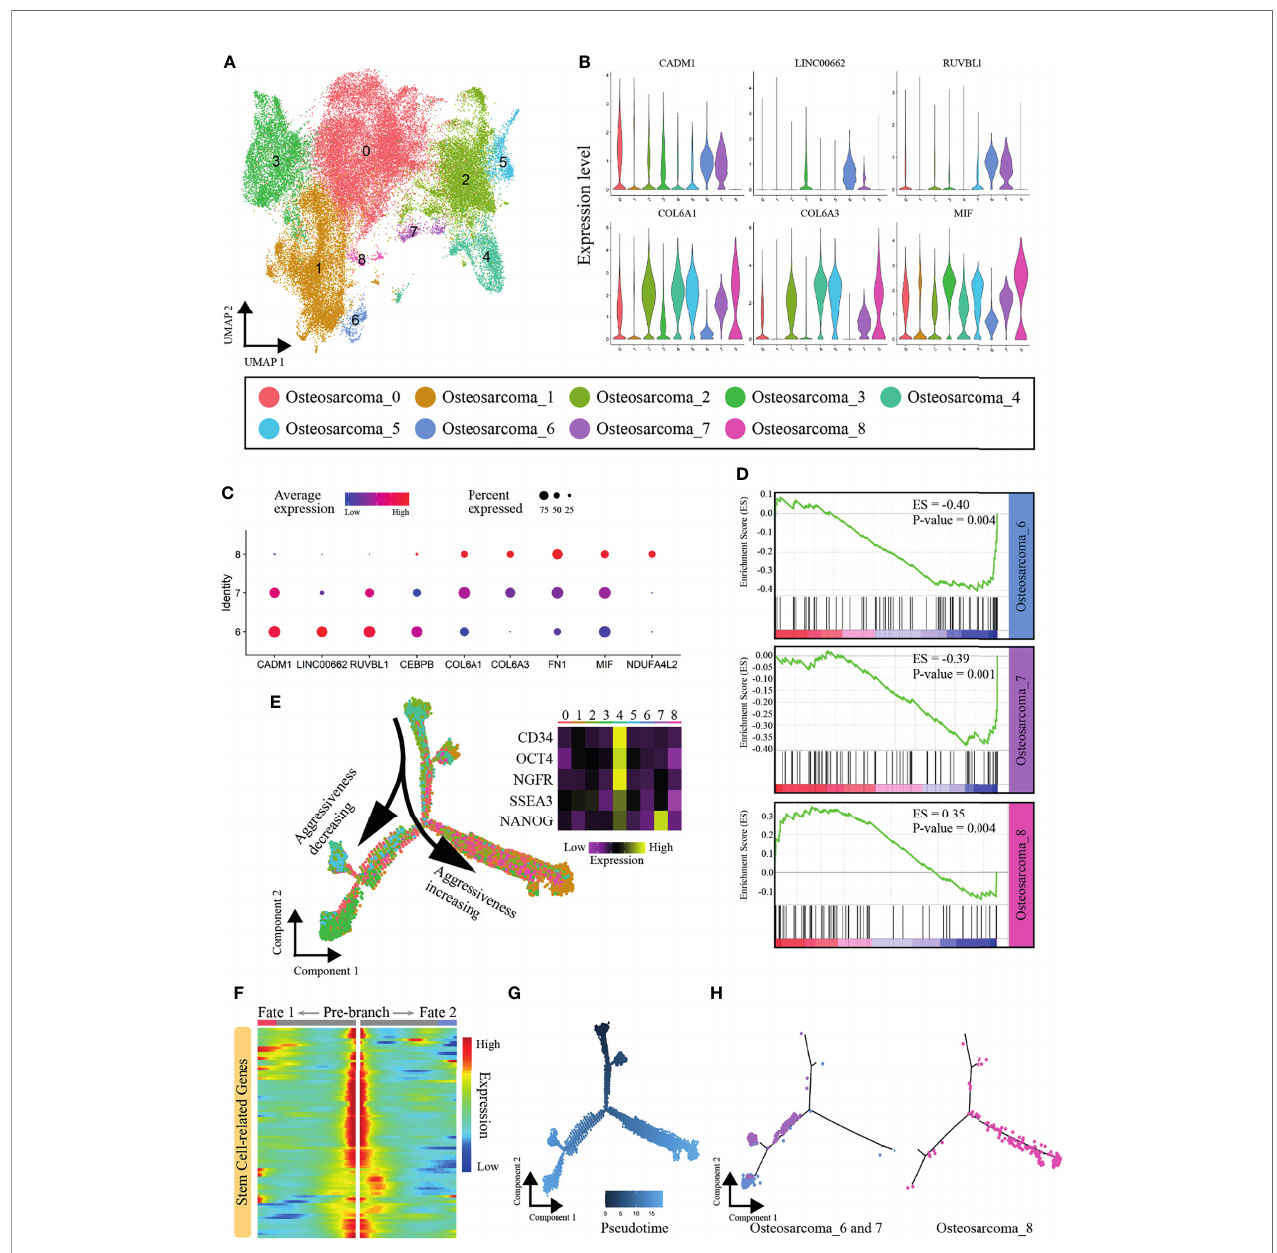
FIGURE 3 | Heterogeneity of OS cells. (A) Nine main OS cell subclusters were identi fi ed by UMAP analysis. (B) Violin plot showing expression levels of some vital genes that promoted or inhibited OS metastasis. (C) Dot plots showing expression of the nine signature genes across the nine subcellular clusters. (D) GSEA results regarding enrichment of the PI3K-AKT signaling pathway in subclusters 6, 7 and 8. (E) Pseudotemporal trajectory plot showing the dynamics of OS subclusters. (F) Heatmap showing expression alterations of stem cell-related genes under different cell fates de fi ned by pseudotime analysis. (G) Pseudotime of OS cells. (H) Differentiation trajectories of subclusters 6, 7 and